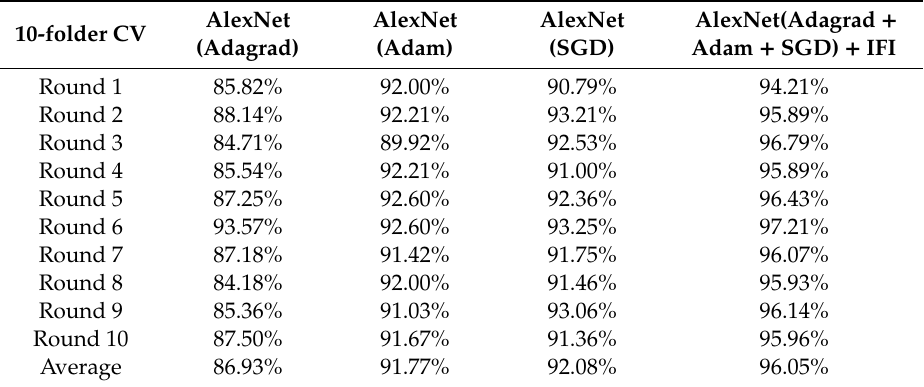
Table 4. Recognition results of AlexNet architectures with di ff erent optimization method.